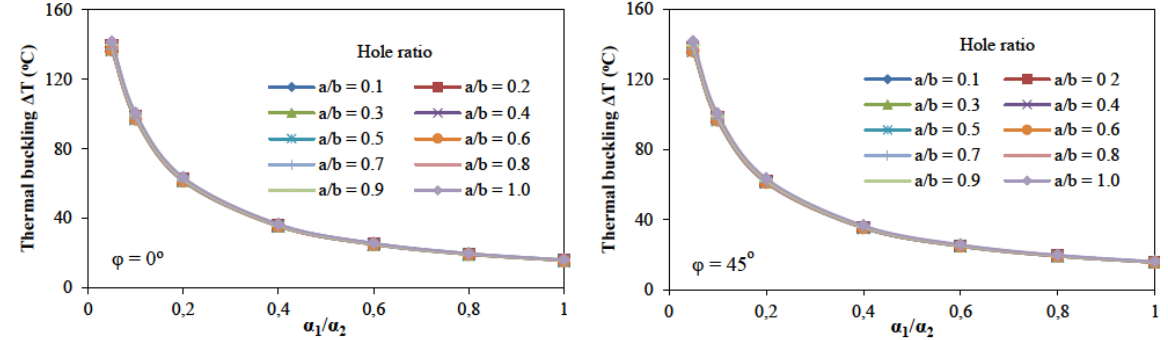
Figure 5: Effect of thermal expansion coeflcient with various hole ratios (a/b).